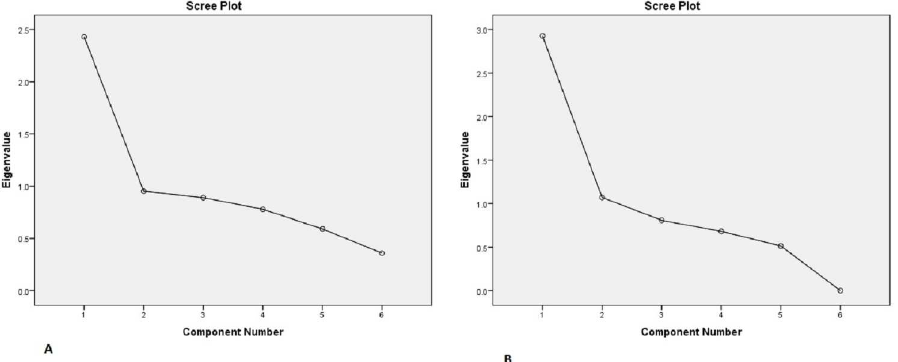
Fig 1. Scree plot of parentalMARS (A) and childrenMARS